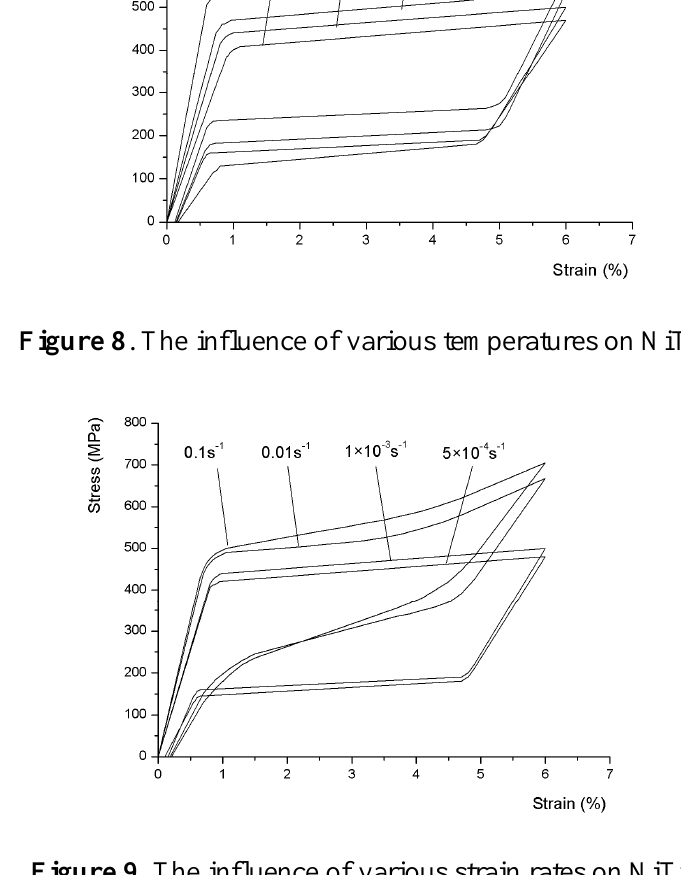
Figure 9 . The influence of various strain rates on NiTi